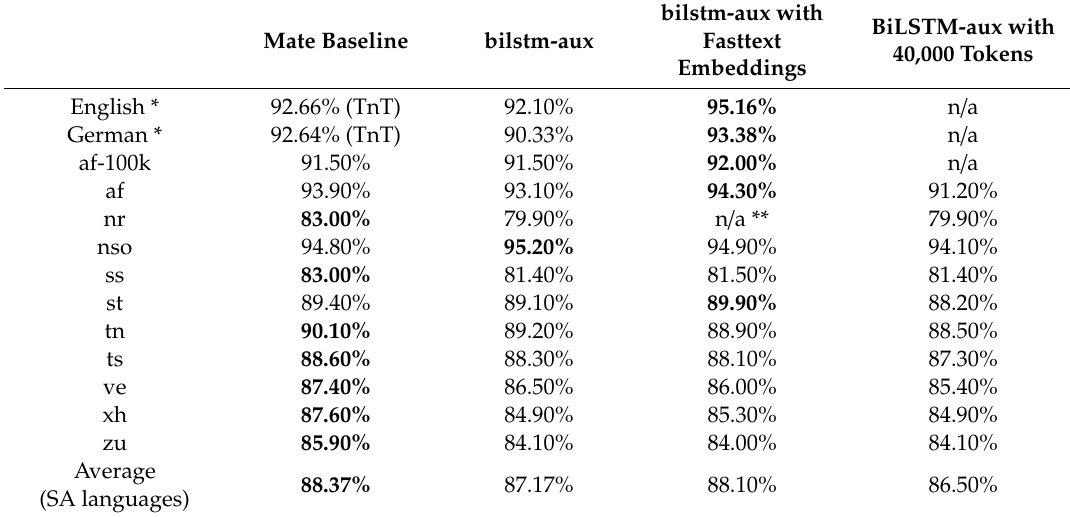
Table 5. POS tagging accuracy; numerically highest scores per language are in bold